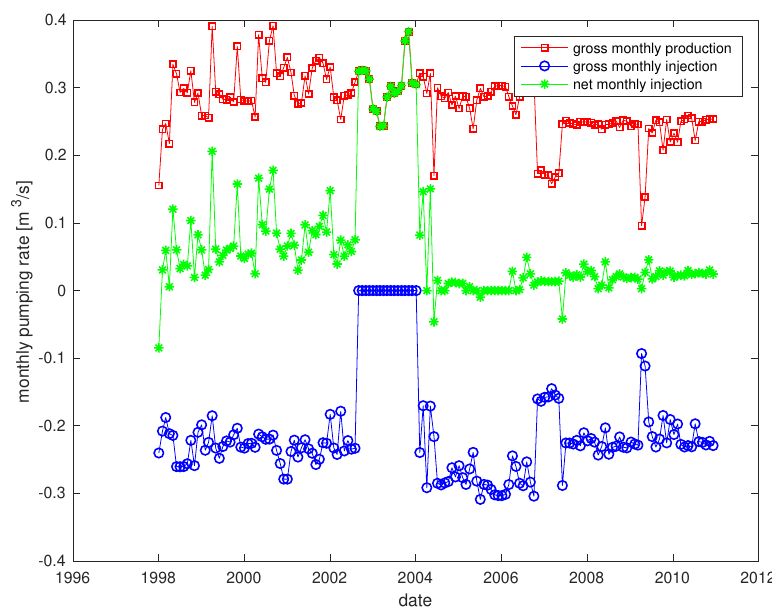
Figure A10. Time series showing rate of gross total monthly injection (blue), gross total monthly production (red), and total monthly net production (green) in m 3 /s. Data are from Ormat as reported to the State of Nevada.